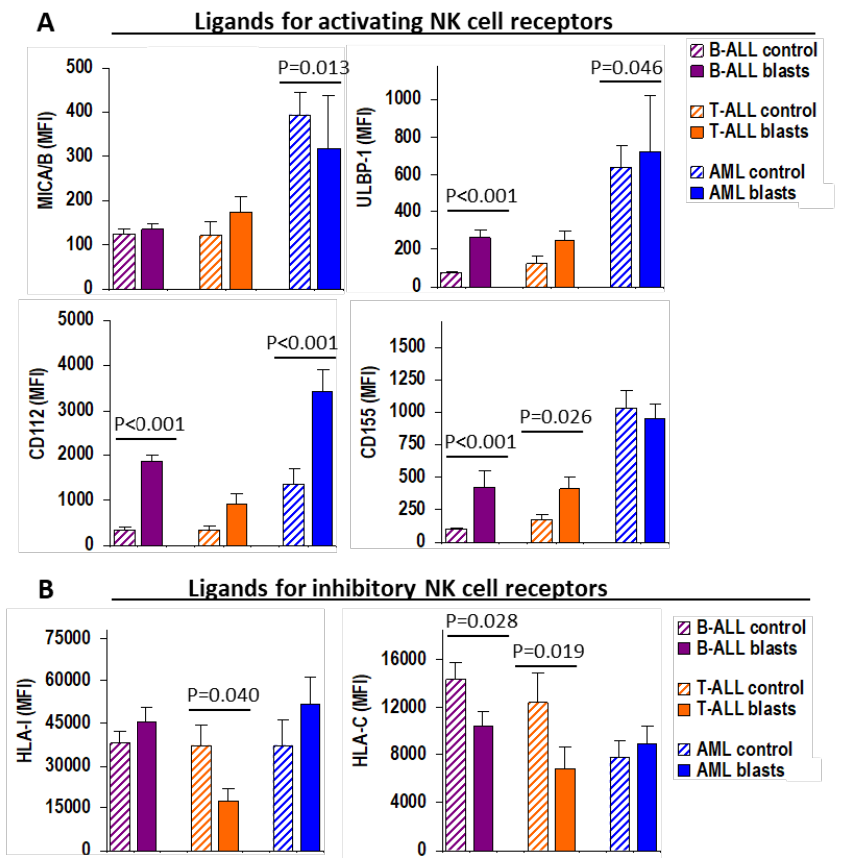
Figure 2. Expression of ligands for NK cell receptors on leukemic blast cells. ( A ) Mean fluorescence intensity (MFI) expression on normal counterpart cells (control, striped bars) and leukemic blast cells (solid bars) of ligands for activating NK cell receptors MICA/B and ULBP (ligands of NKG2D) and CD112 and CD155 (ligands of DNAM-1/CD226). ( B ) Expression of HLA-I and HLA-C ligands for inhibitory receptors (iKIRs and NKG2A). See Figure 7 for details of MFI estimation in leukocyte subset.